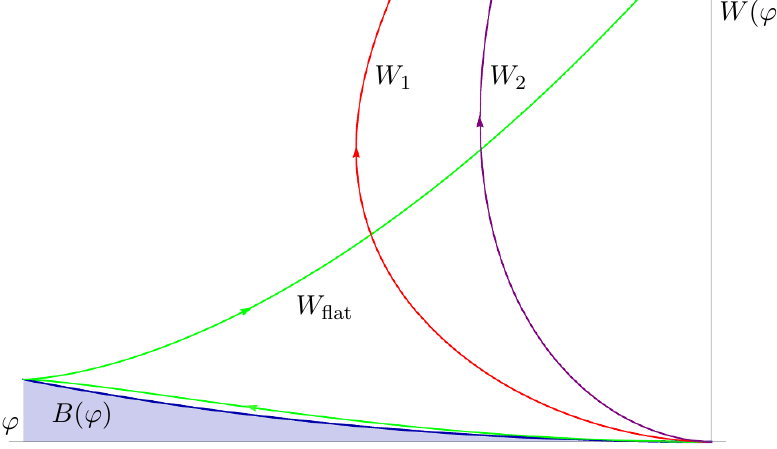
Figure 18. Plot of the potential (5.7) with parameters (cid:1) + = 2 : 91, (cid:27) = 0 : 01, c = 2000, (cid:0) = 2 = ’ (cid:3) = 4.